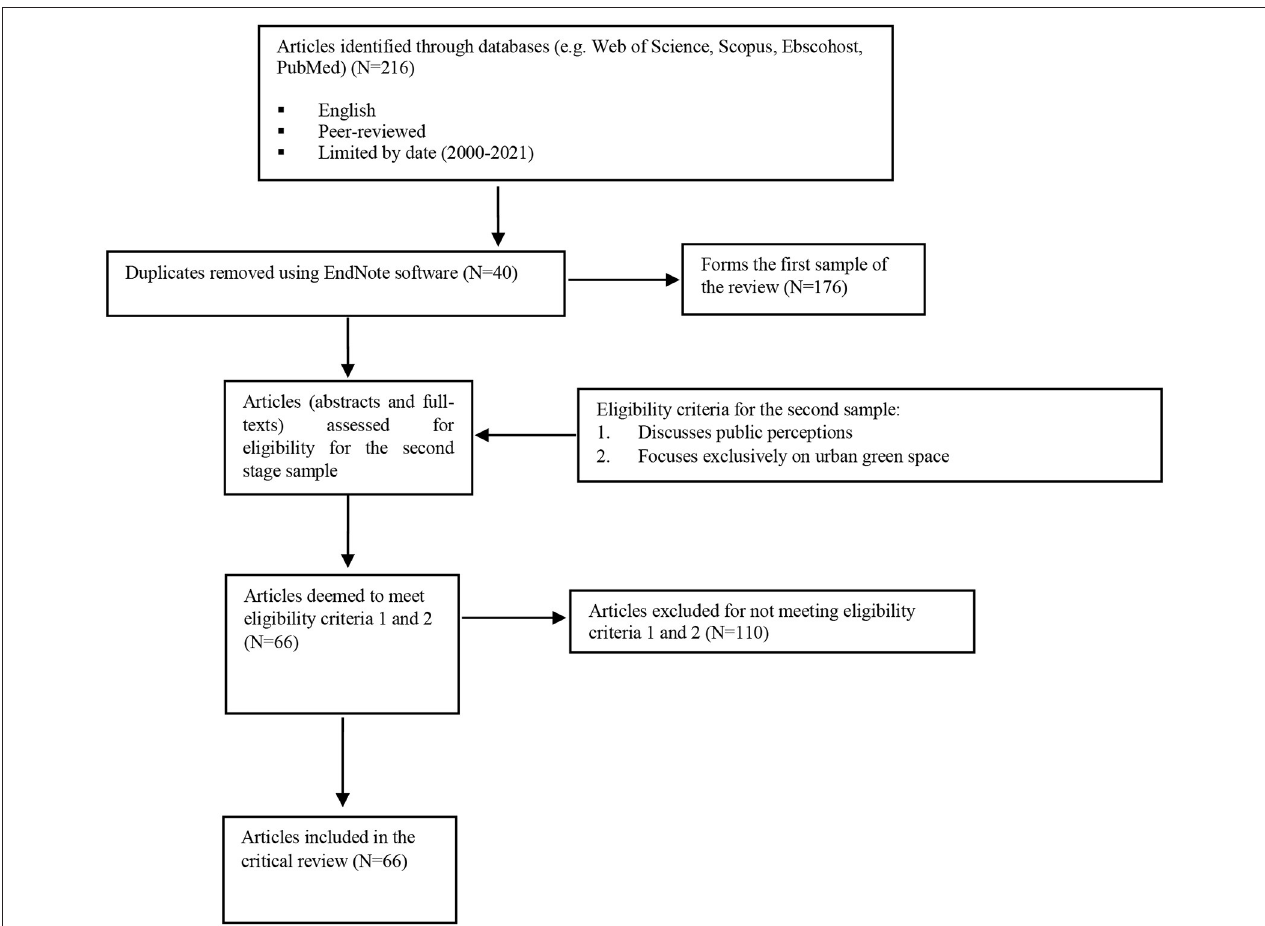
FIGURE 1 | Flow diagram of articles selection process.